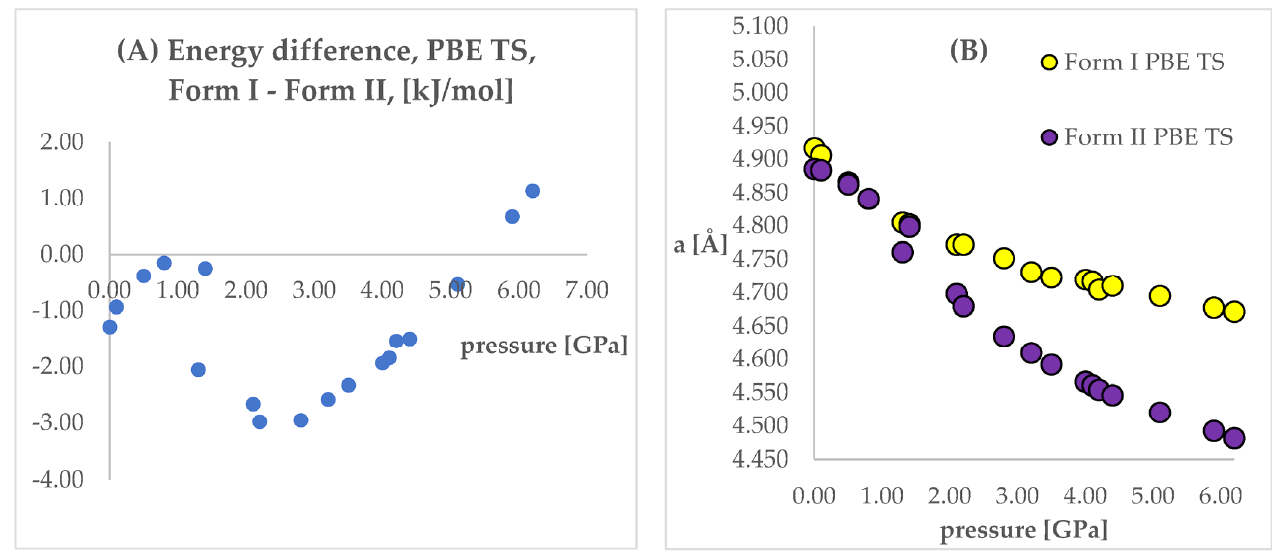
Figure 4. ( A ): Differences between the energies (Form I—Form II) of the structures modeled using PBE TS functional, with respect to pressure. ( B ): The change of unit cell edge “a” length obtained from calculations using PBE TS functional, with respect to pressure. Yellow circles—using Form I as initial; violet circles—using Form II as initial.